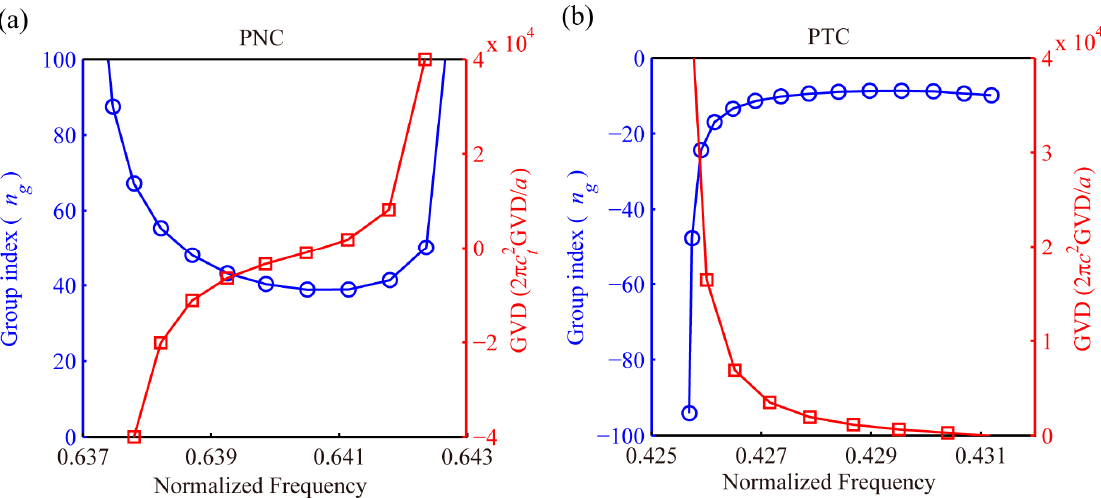
Figure 10. Variations of the group velocity and GVD with the frequency for the SAW ( a ) and SOW ( b ) bands marked with yellow color in Figure 9. Blue and red lines denote the group index and the GVD, respectively. Crystals 2017 , 7 , 350